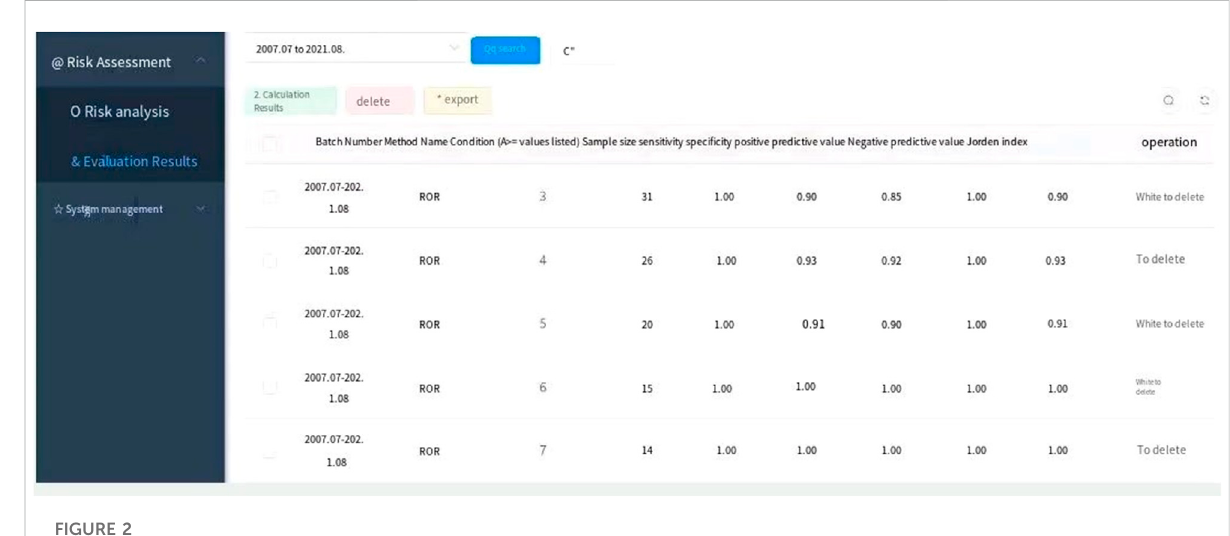
FIGURE 2 Output interface for comparing the results of the four signal detection